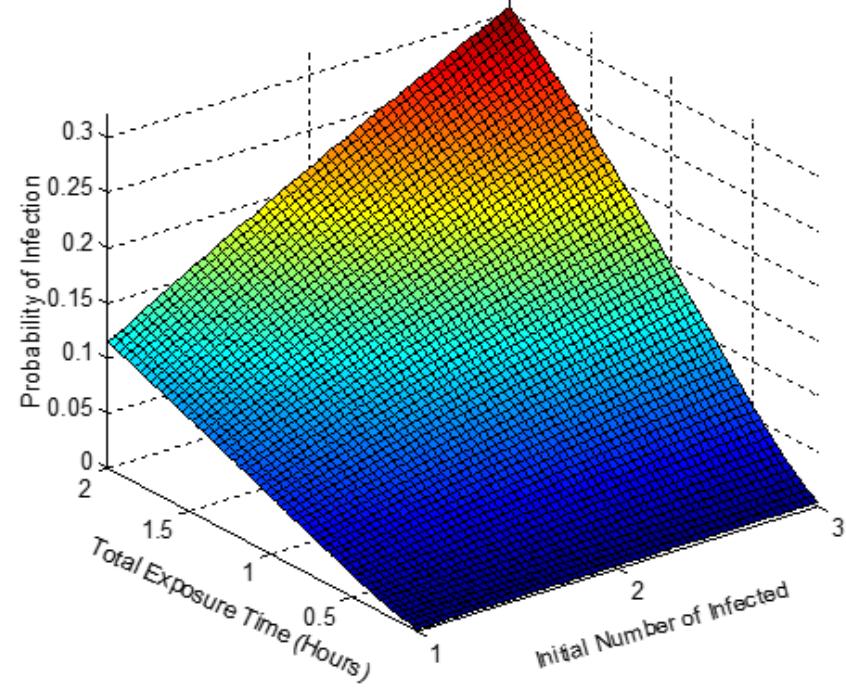
Figure 7. The probability of infection in a single train coach (ladies compartment) with 36 passengers shown as a function of the total exposure time and the initial number of infected.